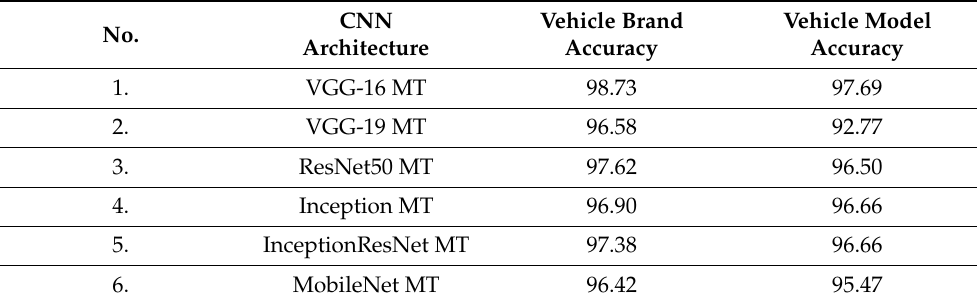
Table 5. Vehicle brand and vehicle model recognition accuracy scores were obtained from the pro- posed method.